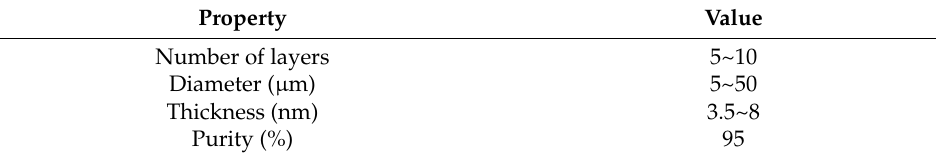
Table 1. Property of graphene oxide.